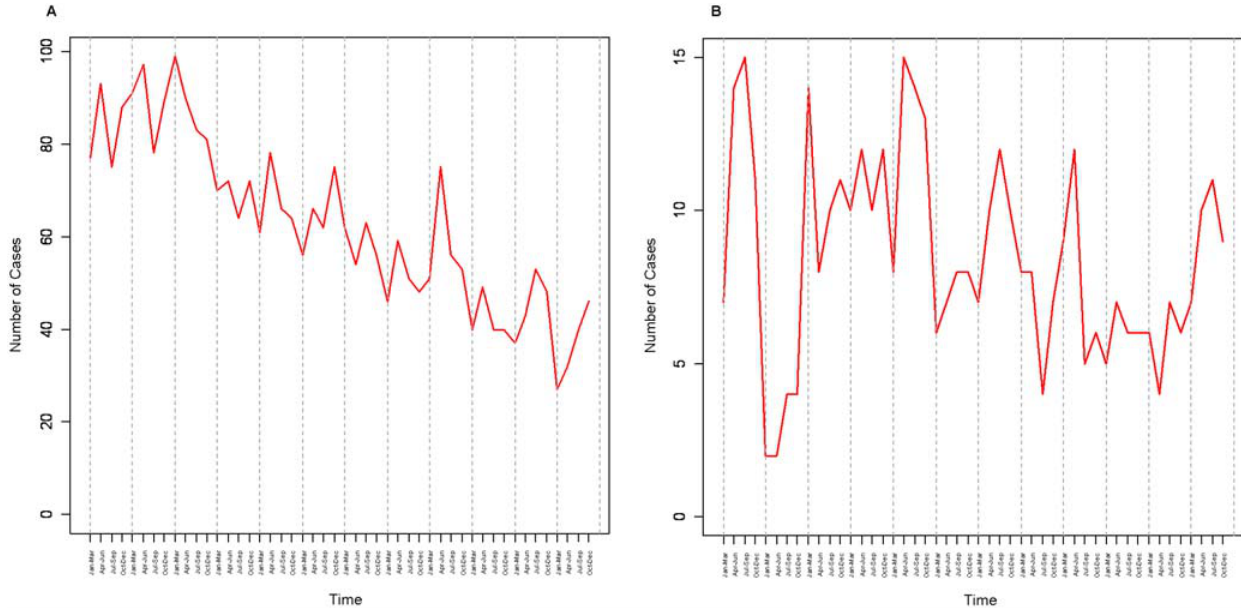
Figure 1. Number of TB cases in San Francisco for the years of 1991–2002: (A) general population, (B) homeless population. Each tick on the x-axis is a summation of TB cases over a three month interval. Grey dashed lines separate each year.